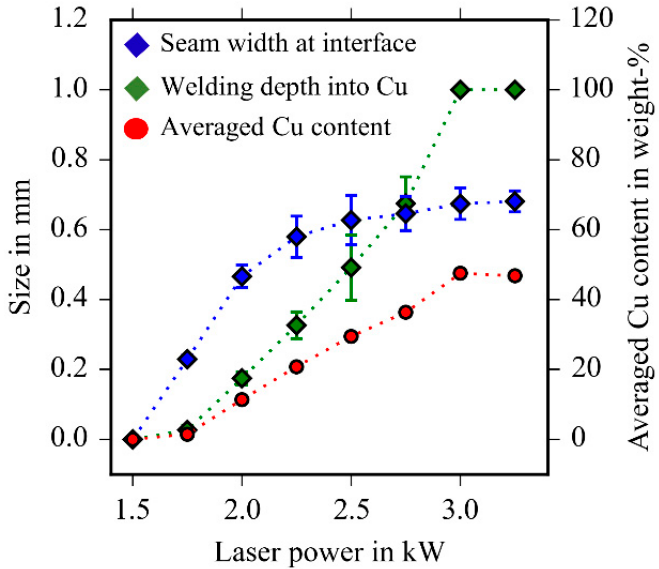
Figure 7. Seam width w at the interface (blue), welding depth d into Cu (green), and averaged Cu content (red) as a function of the laser power for welds produced with rectilinear welding at a feed rate of 6 m/min.